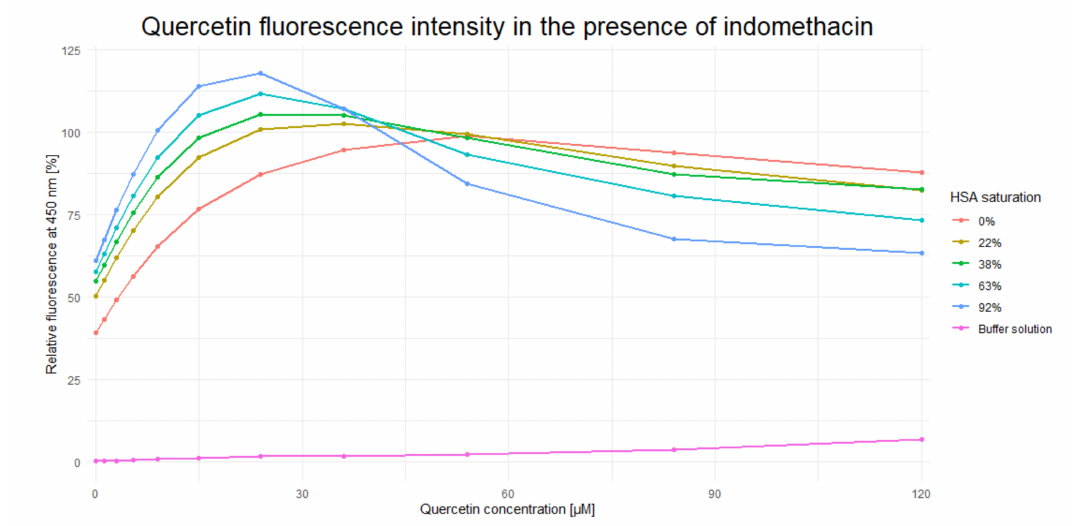
Figure 2. Dependence of quercetin fluorescence ( λ em = 526 nm) on indomethacin